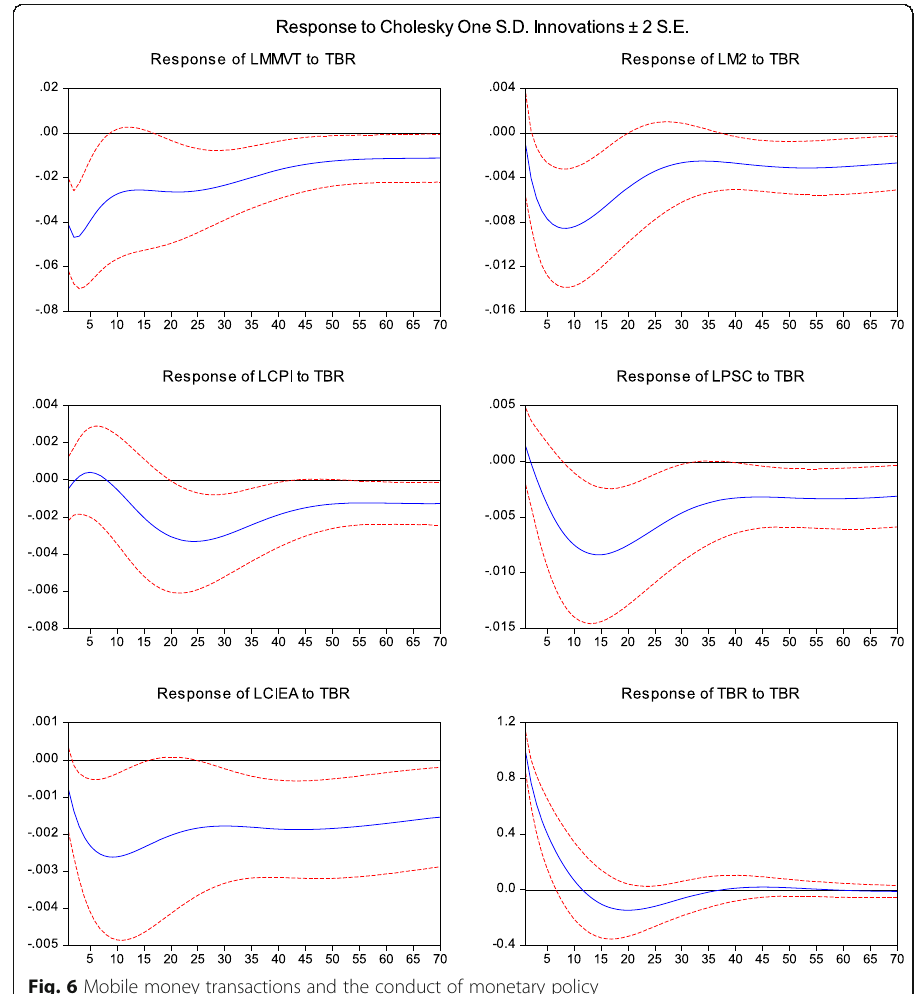
Fig. 6 Mobile money transactions and the conduct of monetary